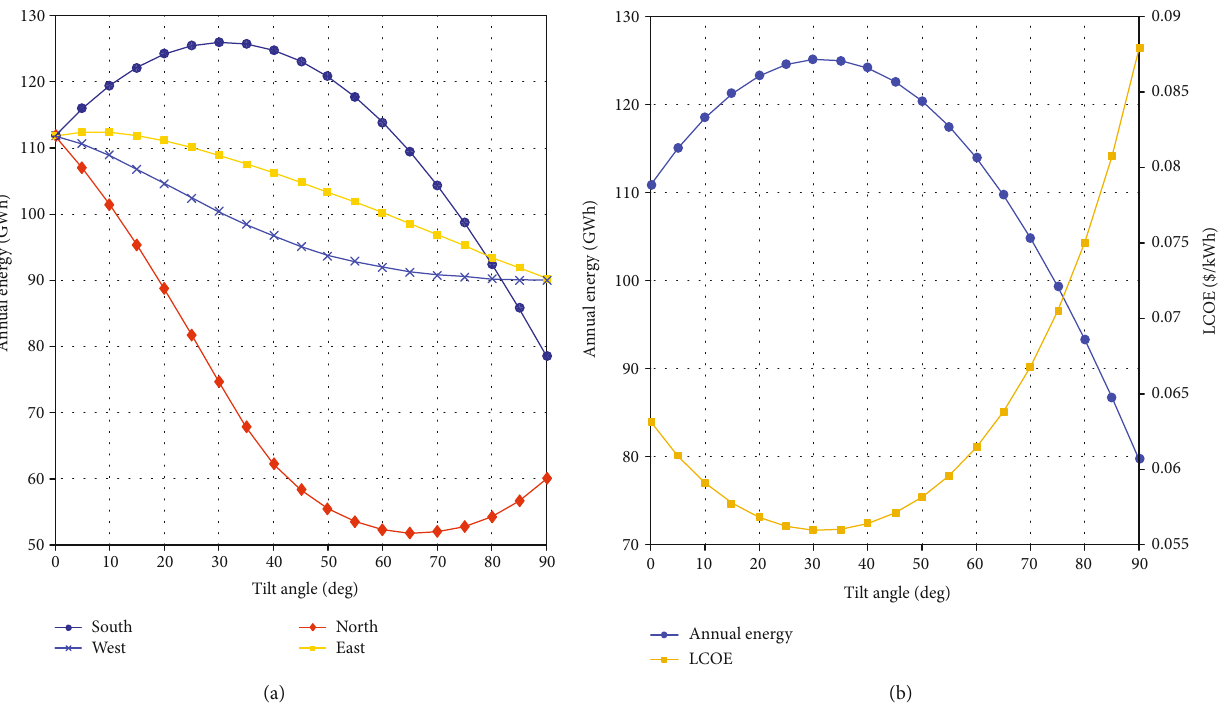
Figure 4: (a) The variation of annual energy for the PV system alone with tilt angle for di ff erent orientations. (b) The variation of annual energy and LCOE for the PV system alone with tilt angle for south